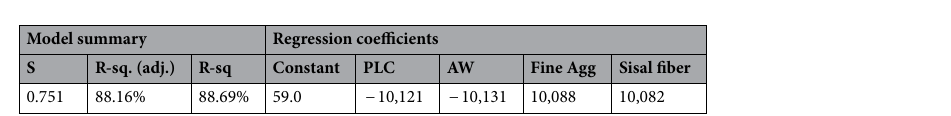
Figure 21. Experimental and ANFIS model results.